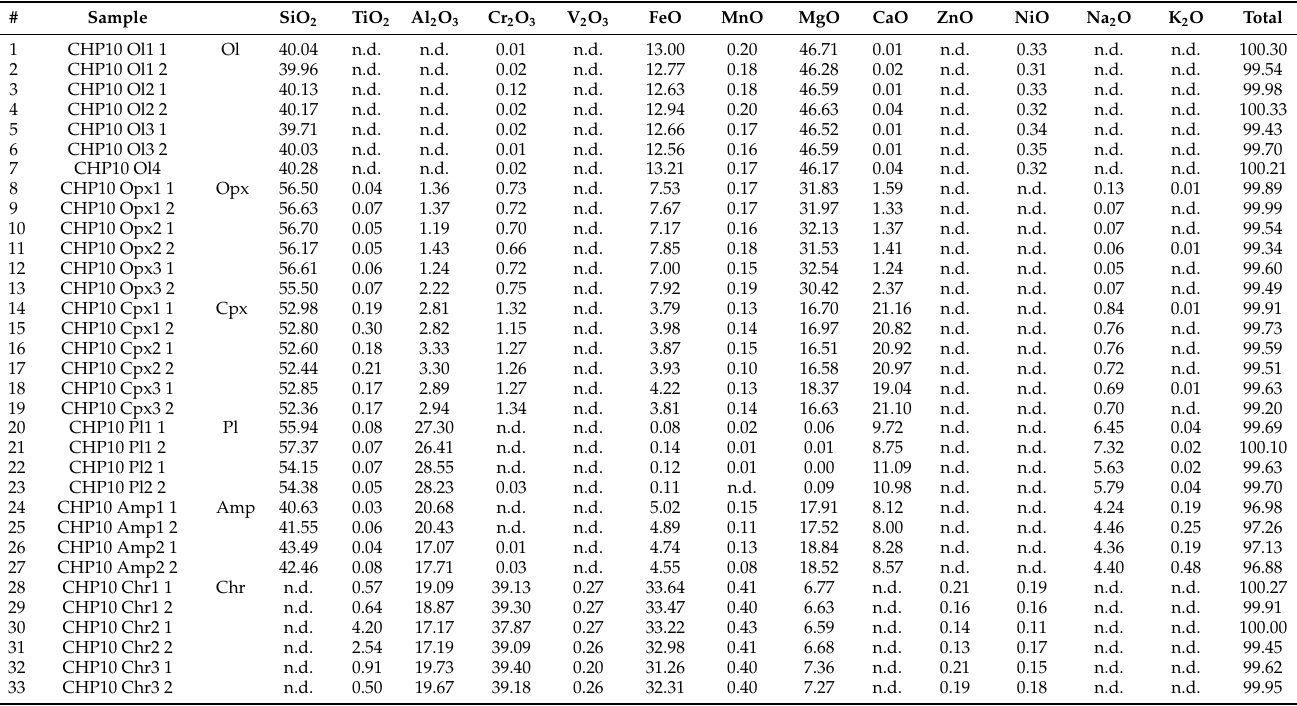
Table 5. Compositions of minerals in a fine-grained harzburgite with a corona-type texture in the Chapesvara-I ultrabasic sill, Kola